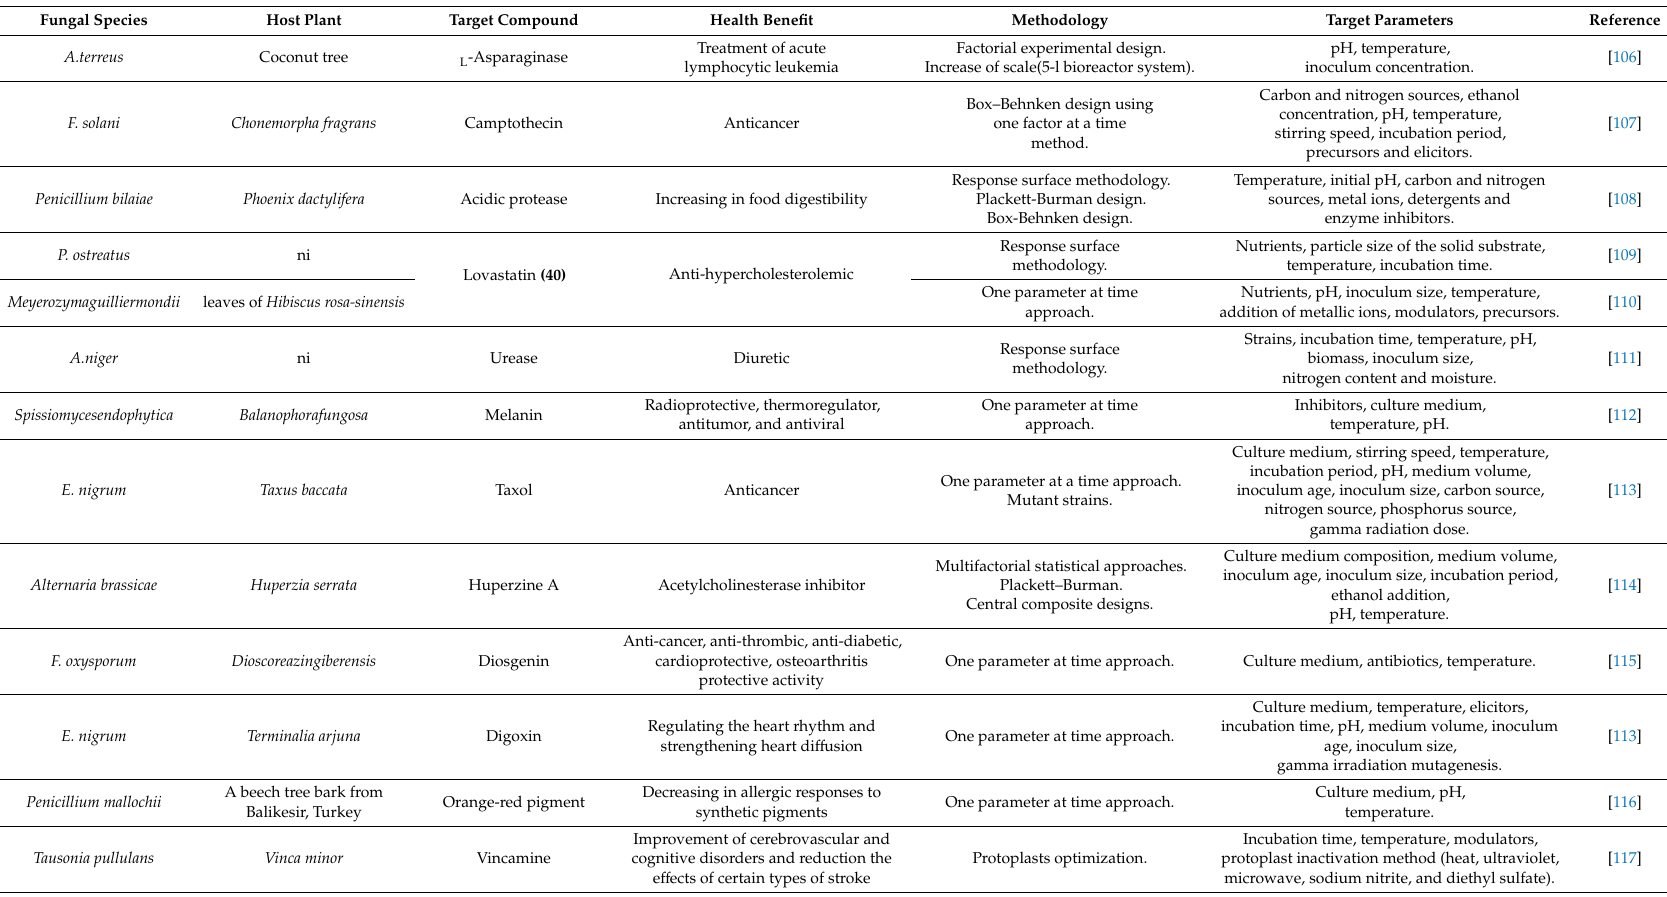
Table 6. Bioactive compounds produced by endophytic fungi under di ff erent fermentation